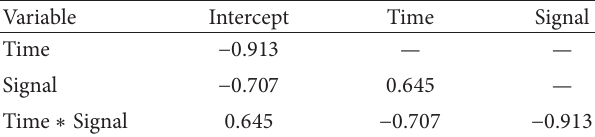
Table 6: Fixed effects for random-effects model.